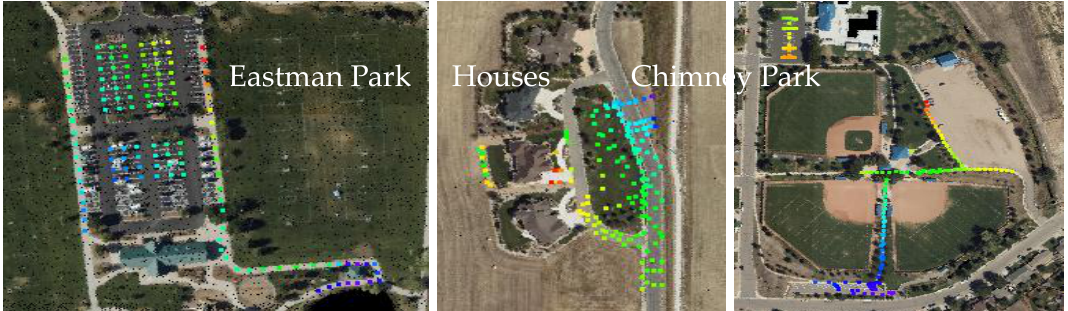
Figure 11. GNSS rover checkpoints for NVA analysis.